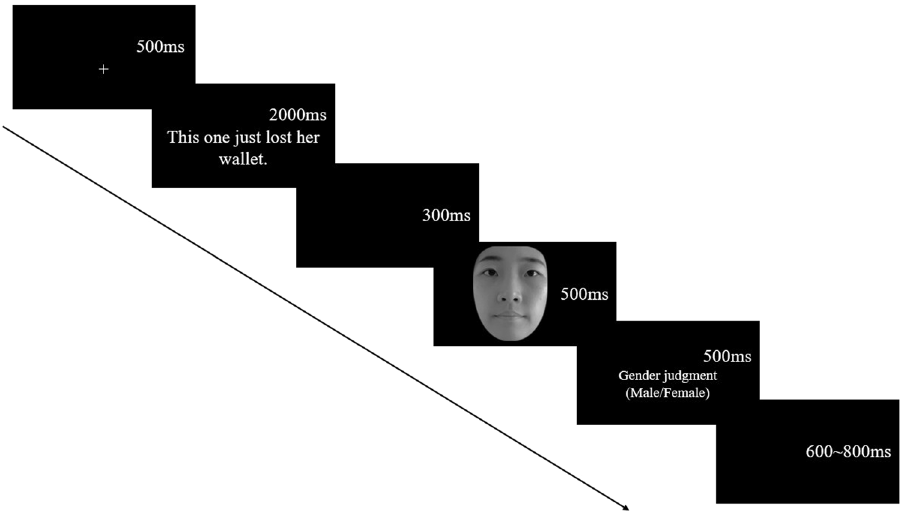
Figure 2. Timings and displays of one trial in the task. (Please reader note that due to the privacy rights, the present pictures were not the stimuli used in the experiment. The model in the sample pictures agreed to publish her pictures in the